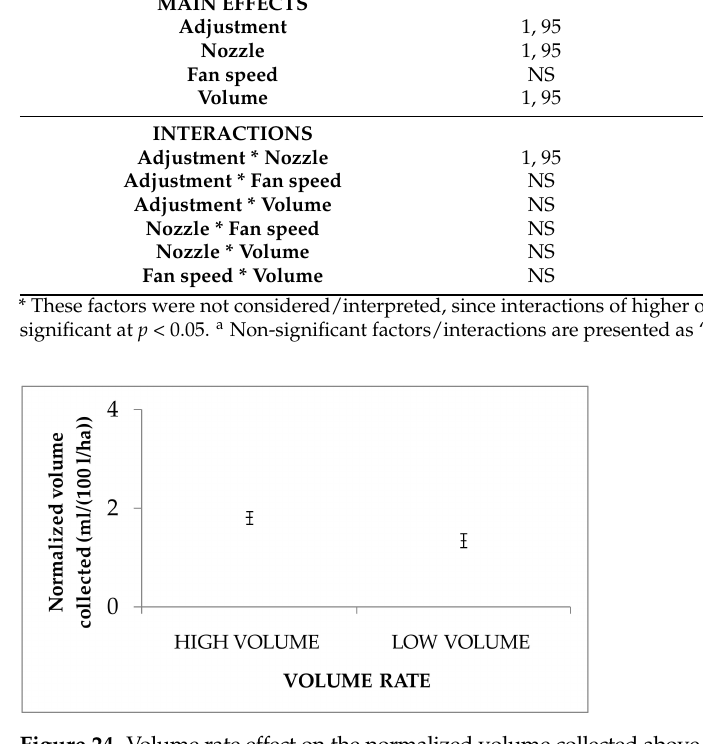
Figure 24. Volume rate effect on the normalized volume collected above the Canopy height (mean ± SE) with the C2 sprayer.